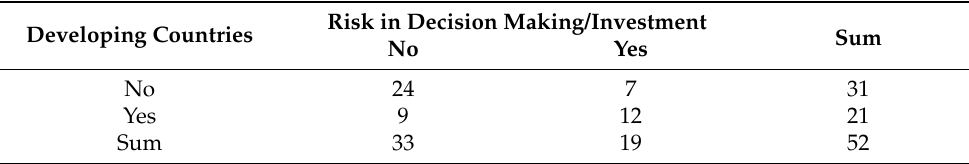
Table 13. Cross-way table for variables: Developing Countries and ESG Risk in Decision Mak- ing/Investment (0.332). Developing Countries